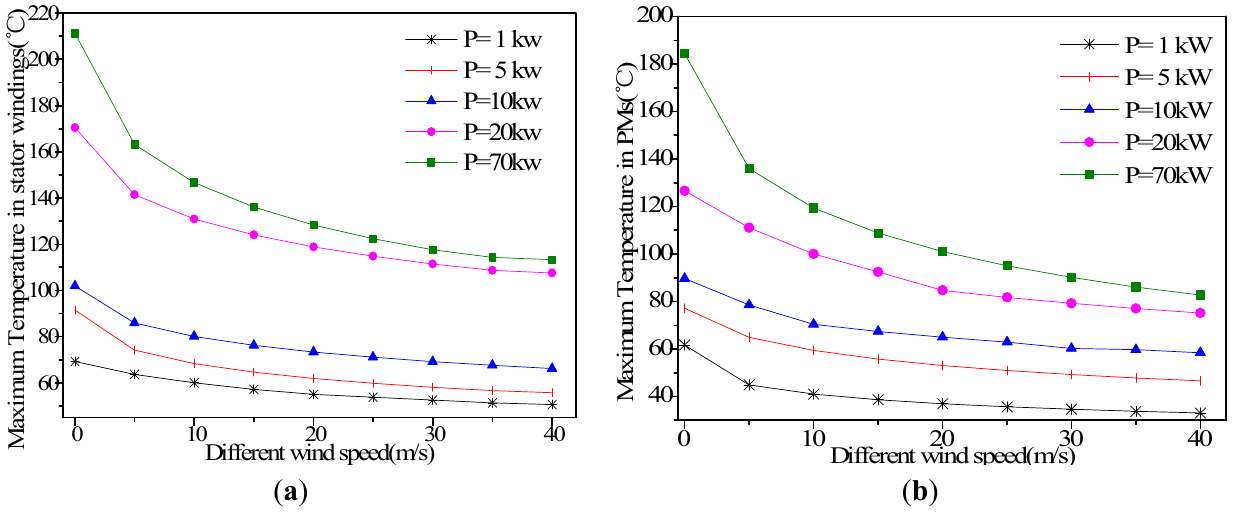
Figure 14. The maximum temperatures versus different wind speed: ( a ) in stator windings; and ( b ) in